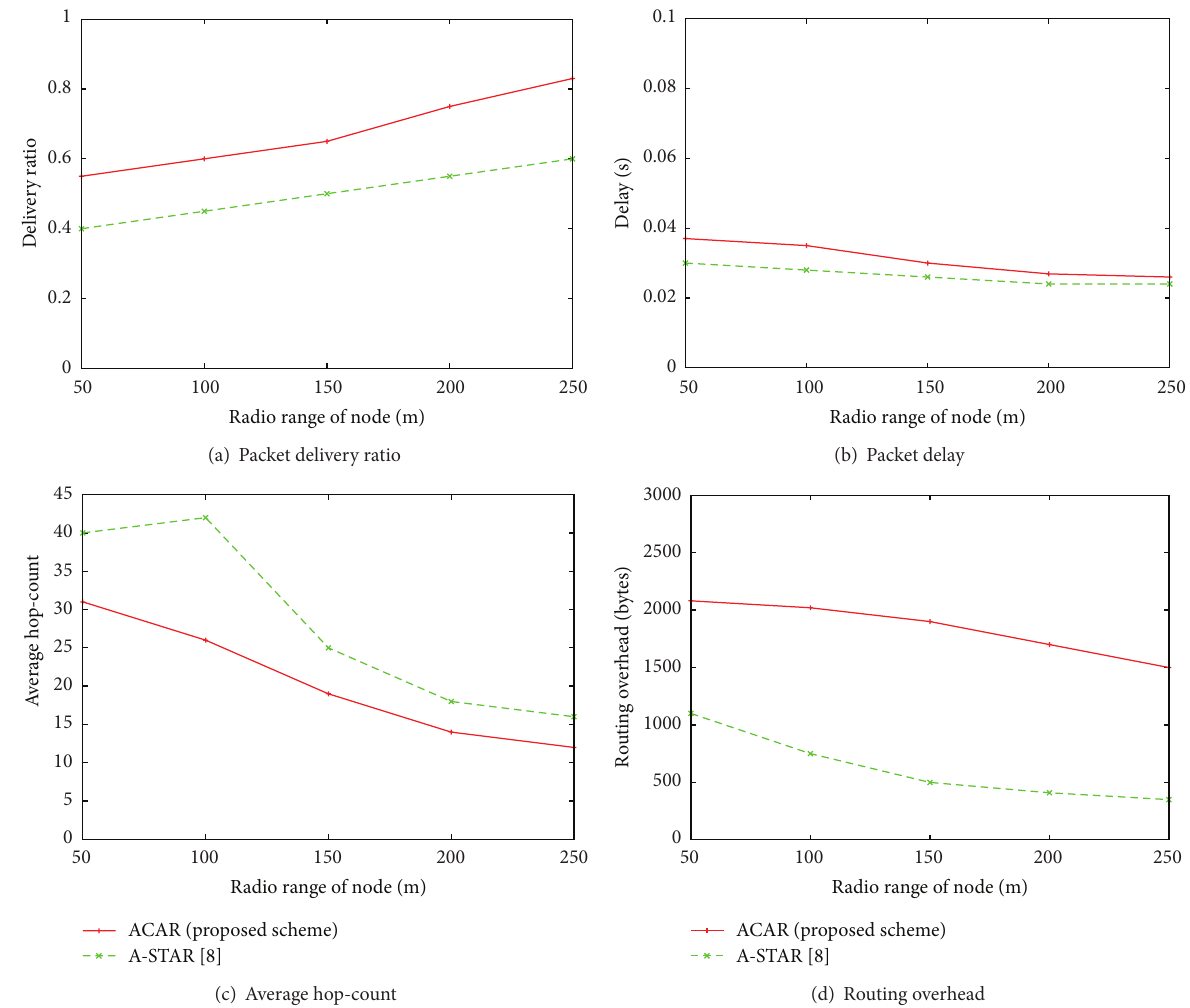
Figure 8: Performance comparison between ACAR (the proposed scheme) and A-STAR according to the radio range of node in terms of packet delivery ratio, packet delay, average hop-count, and routing overhead when the node vehicle’s speed is 50 km/h and the number of nodes is